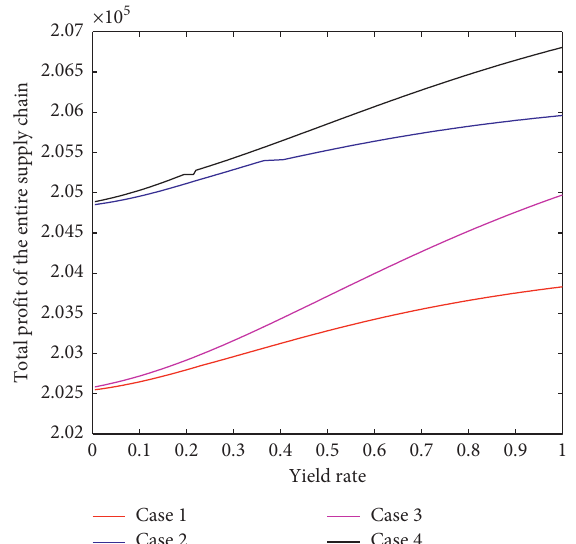
Figure 6: Total profit of the entire supply chain vs. yield rate.